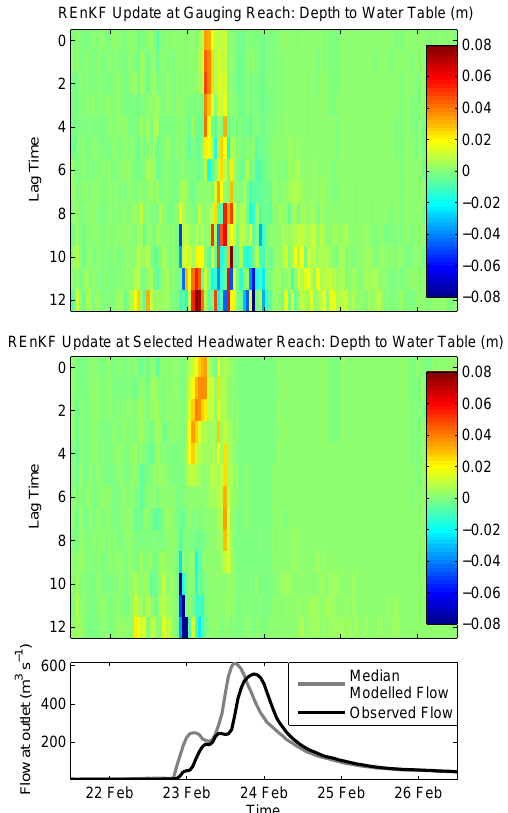
Fig. 12. Size of REnKF update to model state “depth to water table” for the Pomahaka catchment, by observation time and lag time. Up- dates are shown for the gauging station reach (upper panel) and a selected headwater reach (middle panel). Observed and modelled flows at the observation times are shown for comparison (lower